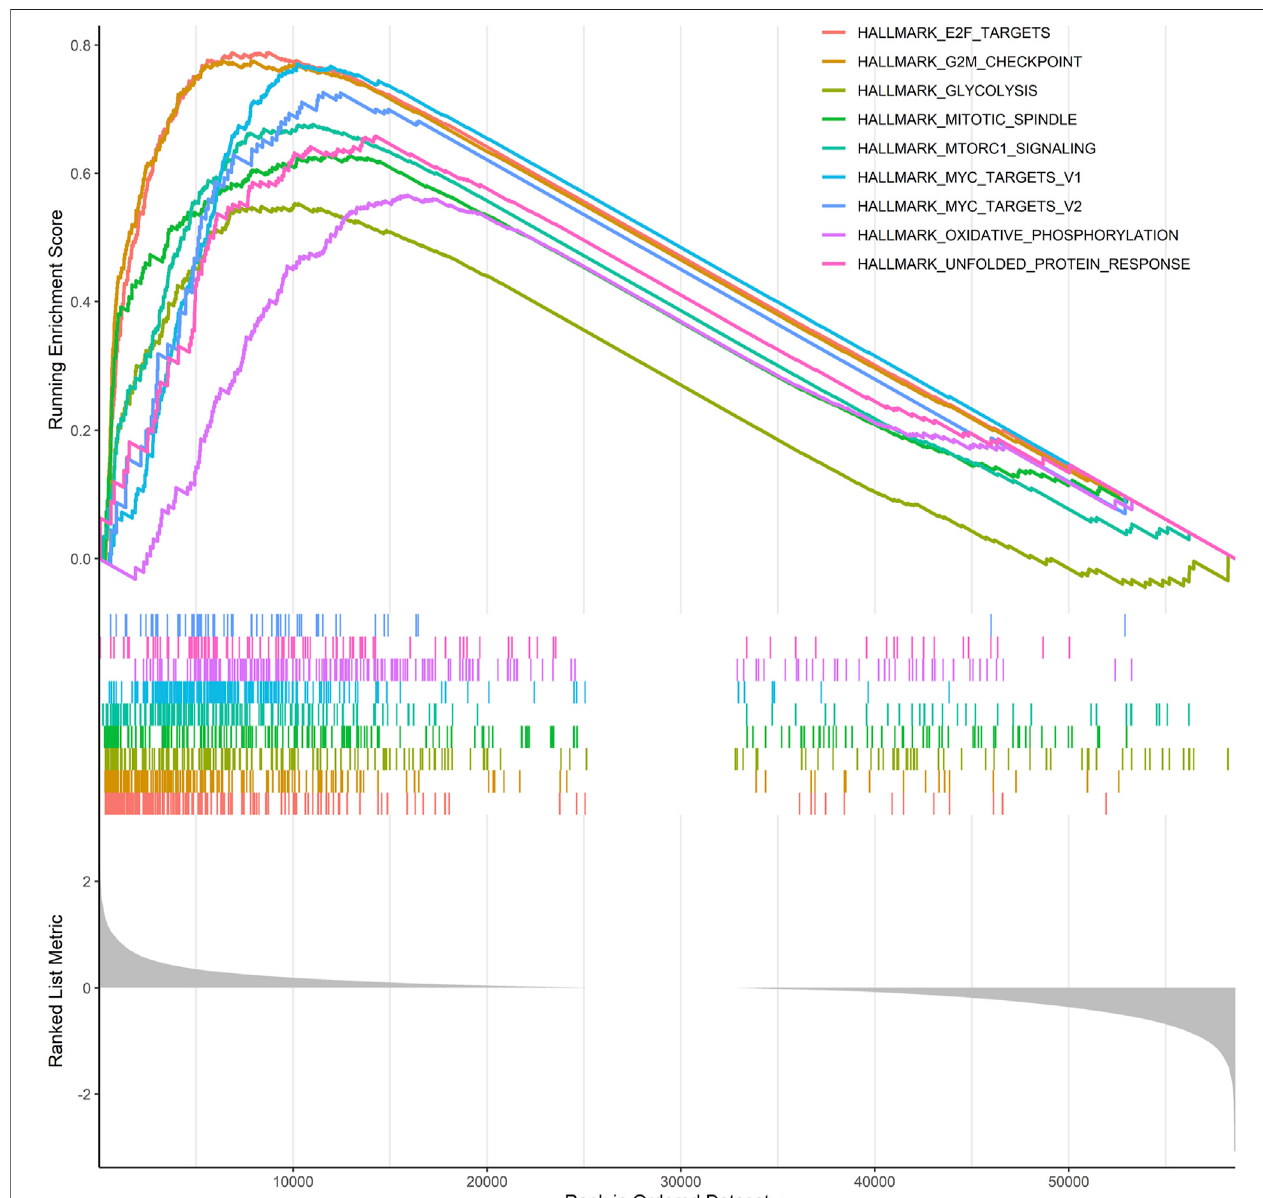
FIGURE 7 | GSEA was performed using the HALLMARK